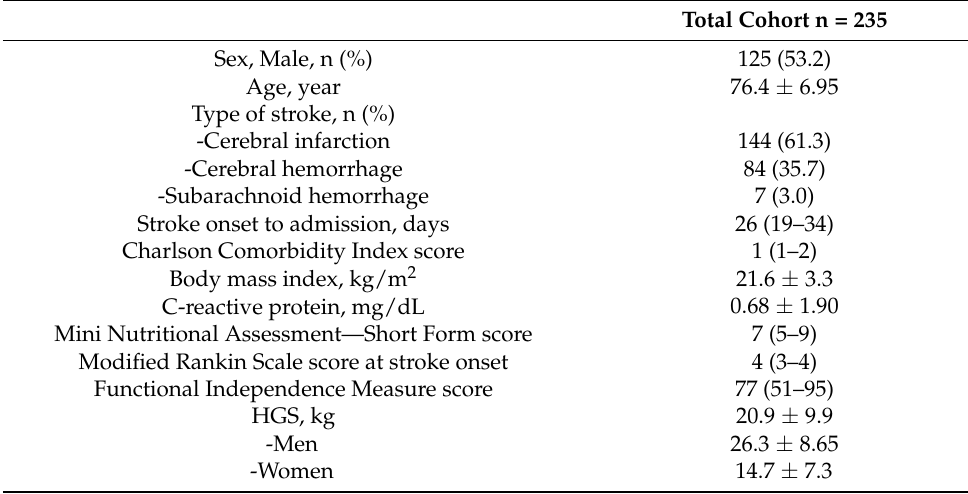
Table 2. Characteristics of the validation